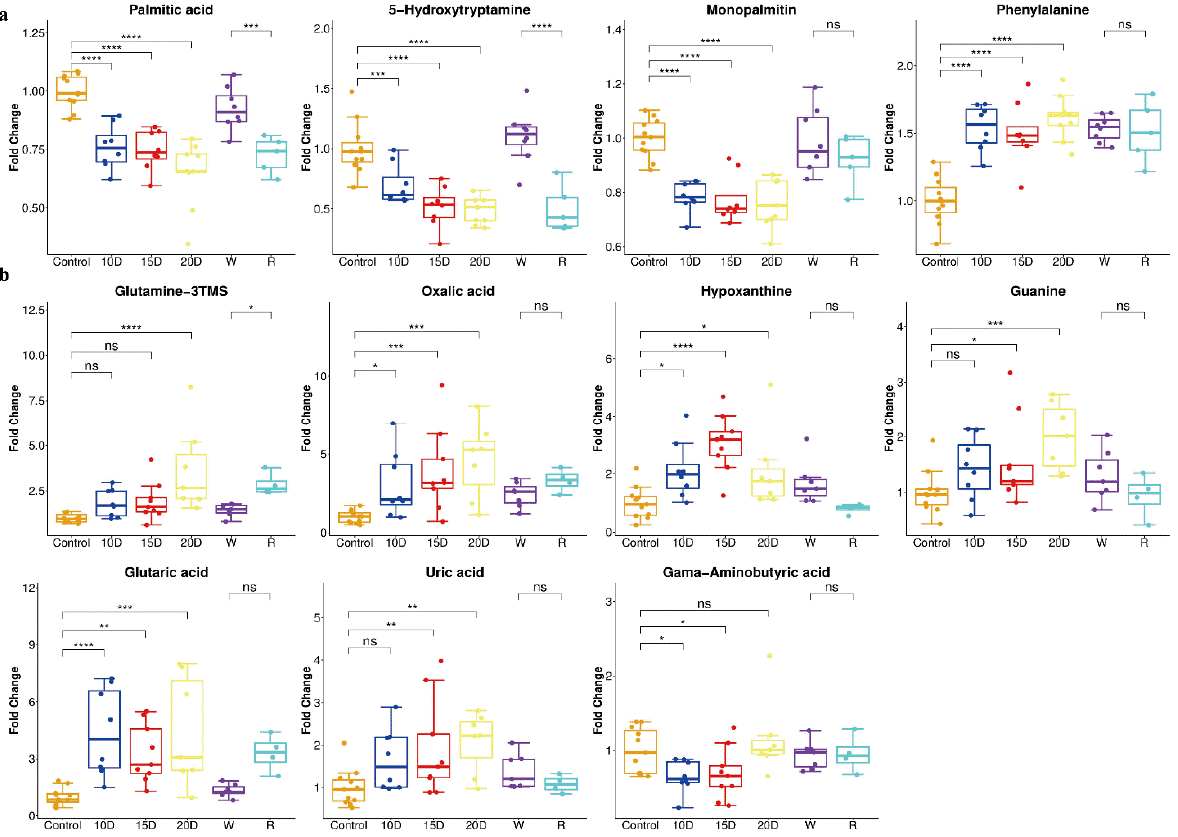
Figure 6. The biomarkers of serum and urine after METH administration. ( a ) The biomarkers of serum after METH administration. ( b ) The biomarkers of urine after METH administration. ns: p > 0.05, *: p < 0.05, **: p < 0.01, ***: p < 0.001, ****: p <